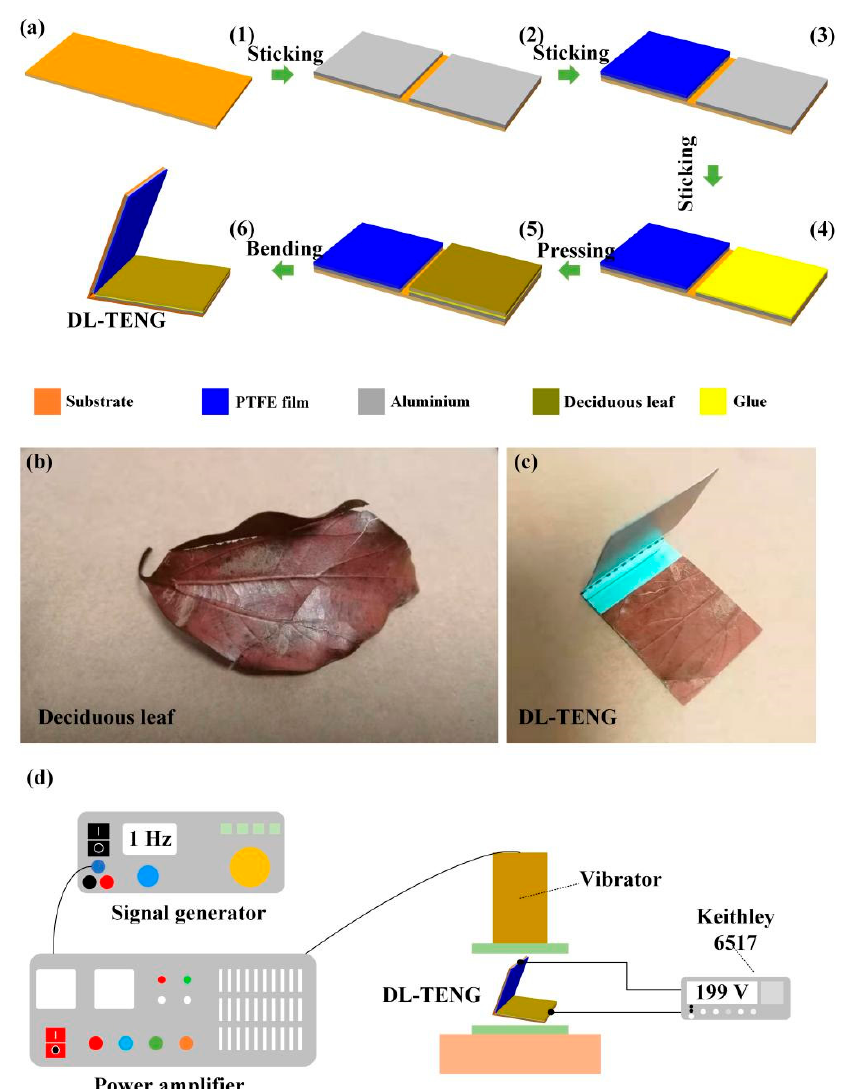
Figure 1. ( a ) The detailed preparation process of deciduous leaf-based triboelectric nanogenerator (DL-TENG) device. ( b ) The photograph of the deciduous leaf. ( c ) The picture of the DL-TENG. ( d ) The schematic view of the testing system.